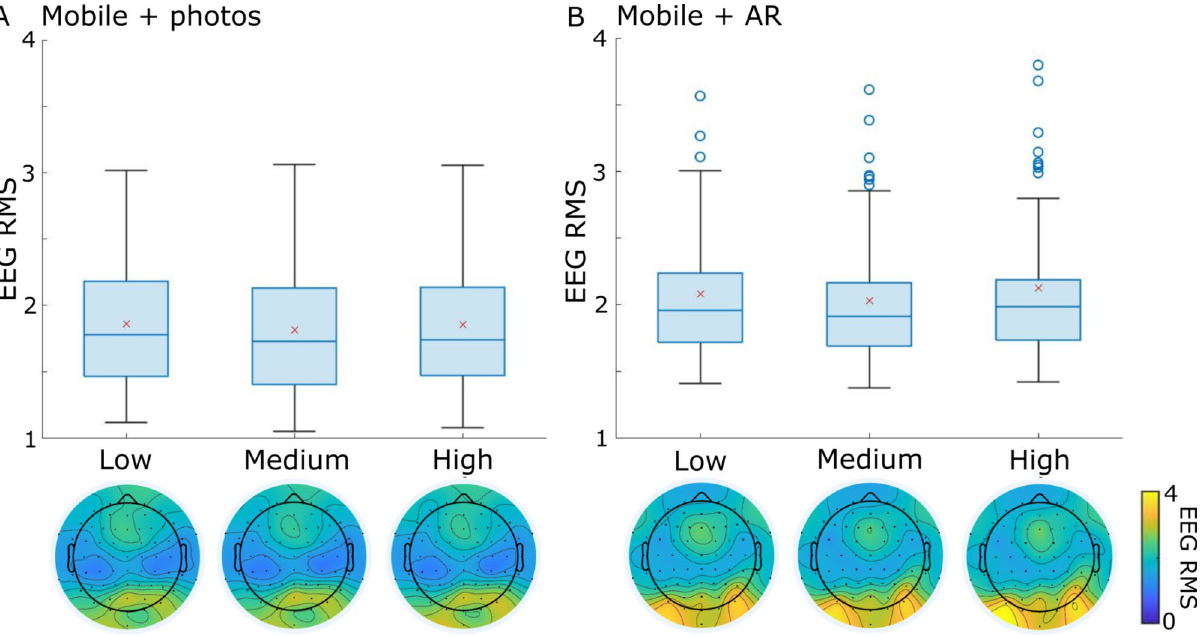
Figure 6. EEG RMS during low, medium and high participant motion for ( A ) the Mobile + photos task and ( B ) the Mobile + AR task. Red x indicates mean RMS over electrodes and participants with boxplots showing the distribution of RMS values across electrodes. Blue circles show outlier electrodes based on RMS values (not motion). Topographies show electrode RMS values for each motion RMS